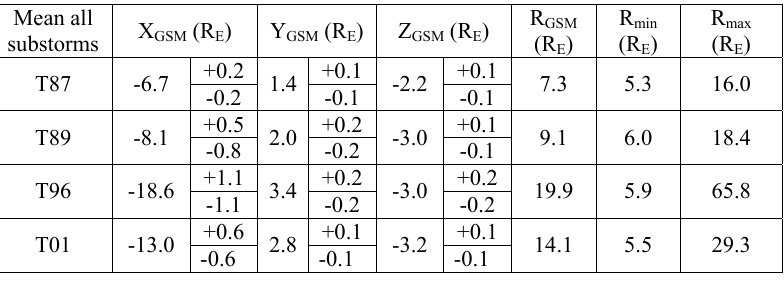
Table 1. Average (X,Y,Z) GSM onset locations determined for the T87, T89, T96, and T01 models. The final three columns give the average, minimum, and maximum radial distance of substorm onsets determined for each model.